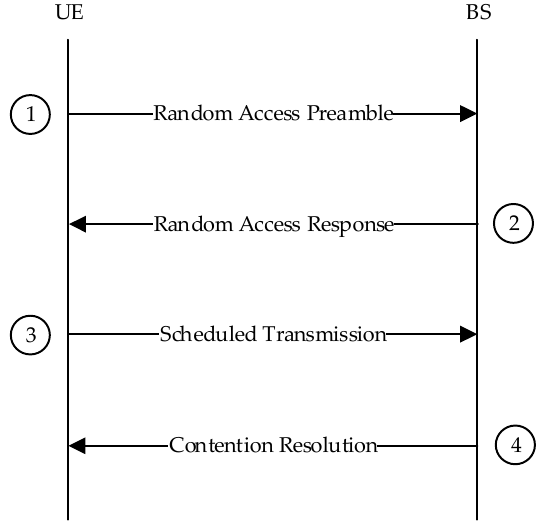
Figure 1. Contention-based random access procedure.